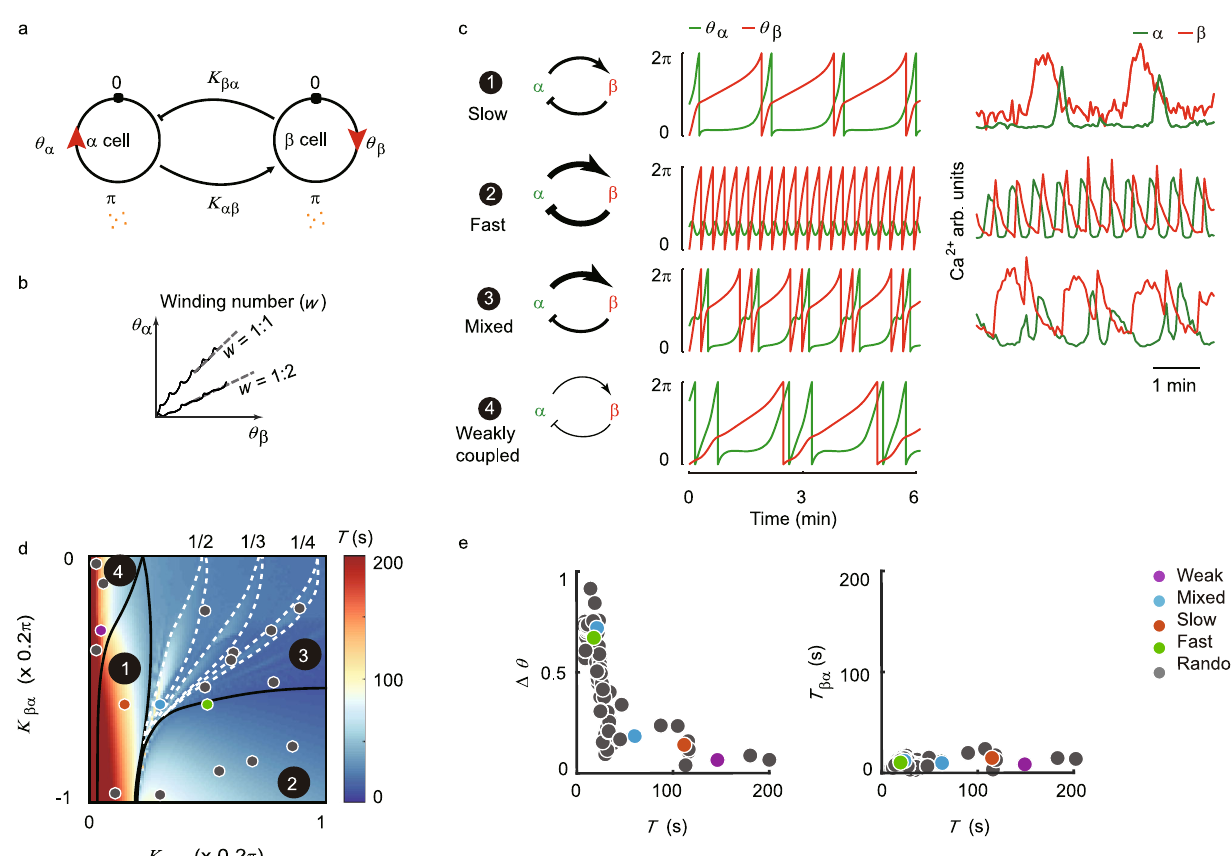
Fig. 5 Mathematical model of islet α and β cells. a Two-cell islet model. The state of each cell is described by its phase θ . Cell secretes hormone at phase π . The hormone secreted by α cell stimulates β cell (with strength K αβ ), and the effect of β cell activation inhibits α cell (with strength K βα ). b Illustration of winding number ( w ) de fi nition. Two examples are shown. Solid lines are the actual trajectories of two solutions of the equations, and dotted lines are straight lines representing the asymptotic limits of the trajectories that de fi ne the winding number. c Left panel: Schematic of α and β cells ’ interaction strengths. Four cases from the four regions in d are shown. Middle panel: Example traces of θ α and θ β in the four cases, respectively. The parameters used in these examples are indicated by the four colored dots in d . Right panel: Corresponding examples of Ca 2 + traces found experimentally for the fi rst three cases. d The phase diagram of the system. Depending on the two coupling constants K αβ and K β α , the oscillatory behavior of the two cells falls into one of the four phase-locked regions, characterized by the winding number w . In region 3, any rational winding number w < 1 has a stable phase-locking region. For clarity, only the phase-locking regions for lower-order rational numbers (1/2, 1/3 and 1/4) are shown. Color bar codes the period of the oscillation. Except for the four colored dots, 15 randomly selected gray dots are also shown. e Scatter plots of Δ θ and T βα versus T . Each dot represents one oscillation cycle. The color of the dot indicates the parameters used in the simulation, which are shown in phase diagram ( d ) with the same